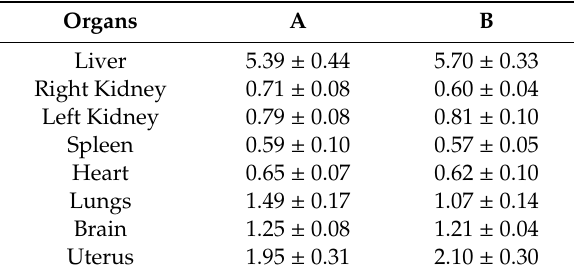
Table 2. Relative organ weights in % (mean ± SEM) of female ICR mice in acute toxicity study of CELE.